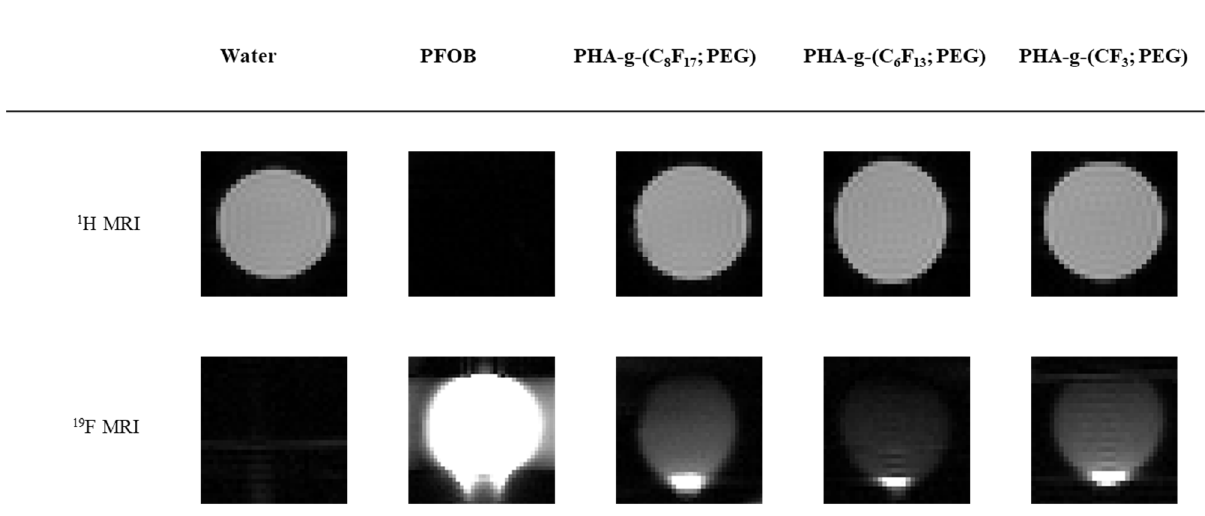
Figure 9. In vitro 1 H MRI and 19 F MRI phantom images of the different nanocapsules containing PFOB. (RARE factor = 64; TE = 23.3 ms, TR = 4550 ms; scan time = 15 min 10 s).